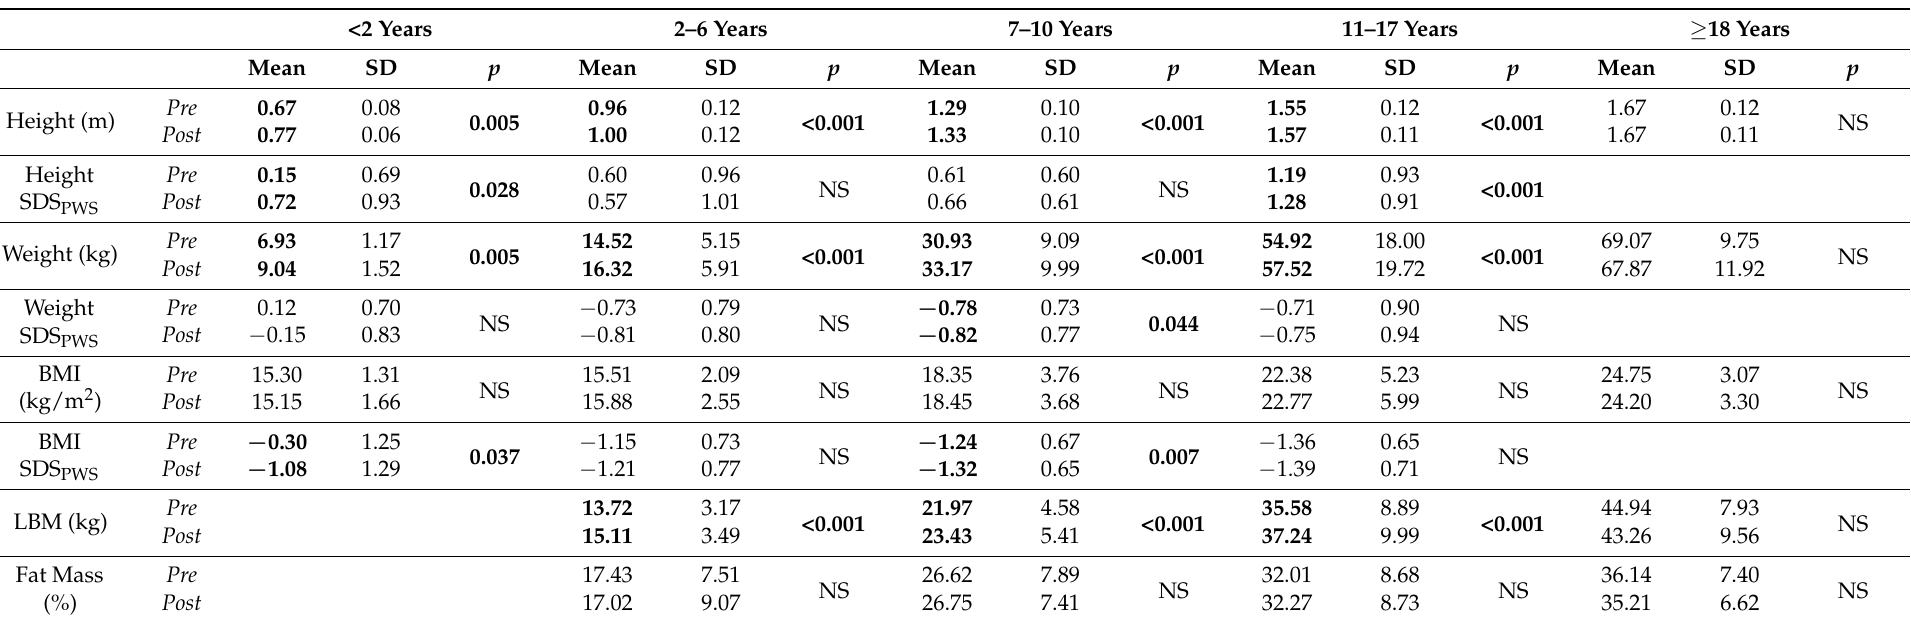
Table 2. Anthropometric parameters before and after the lockdown in March–April 2020. p -values > 0.05 depicted as “NS”.